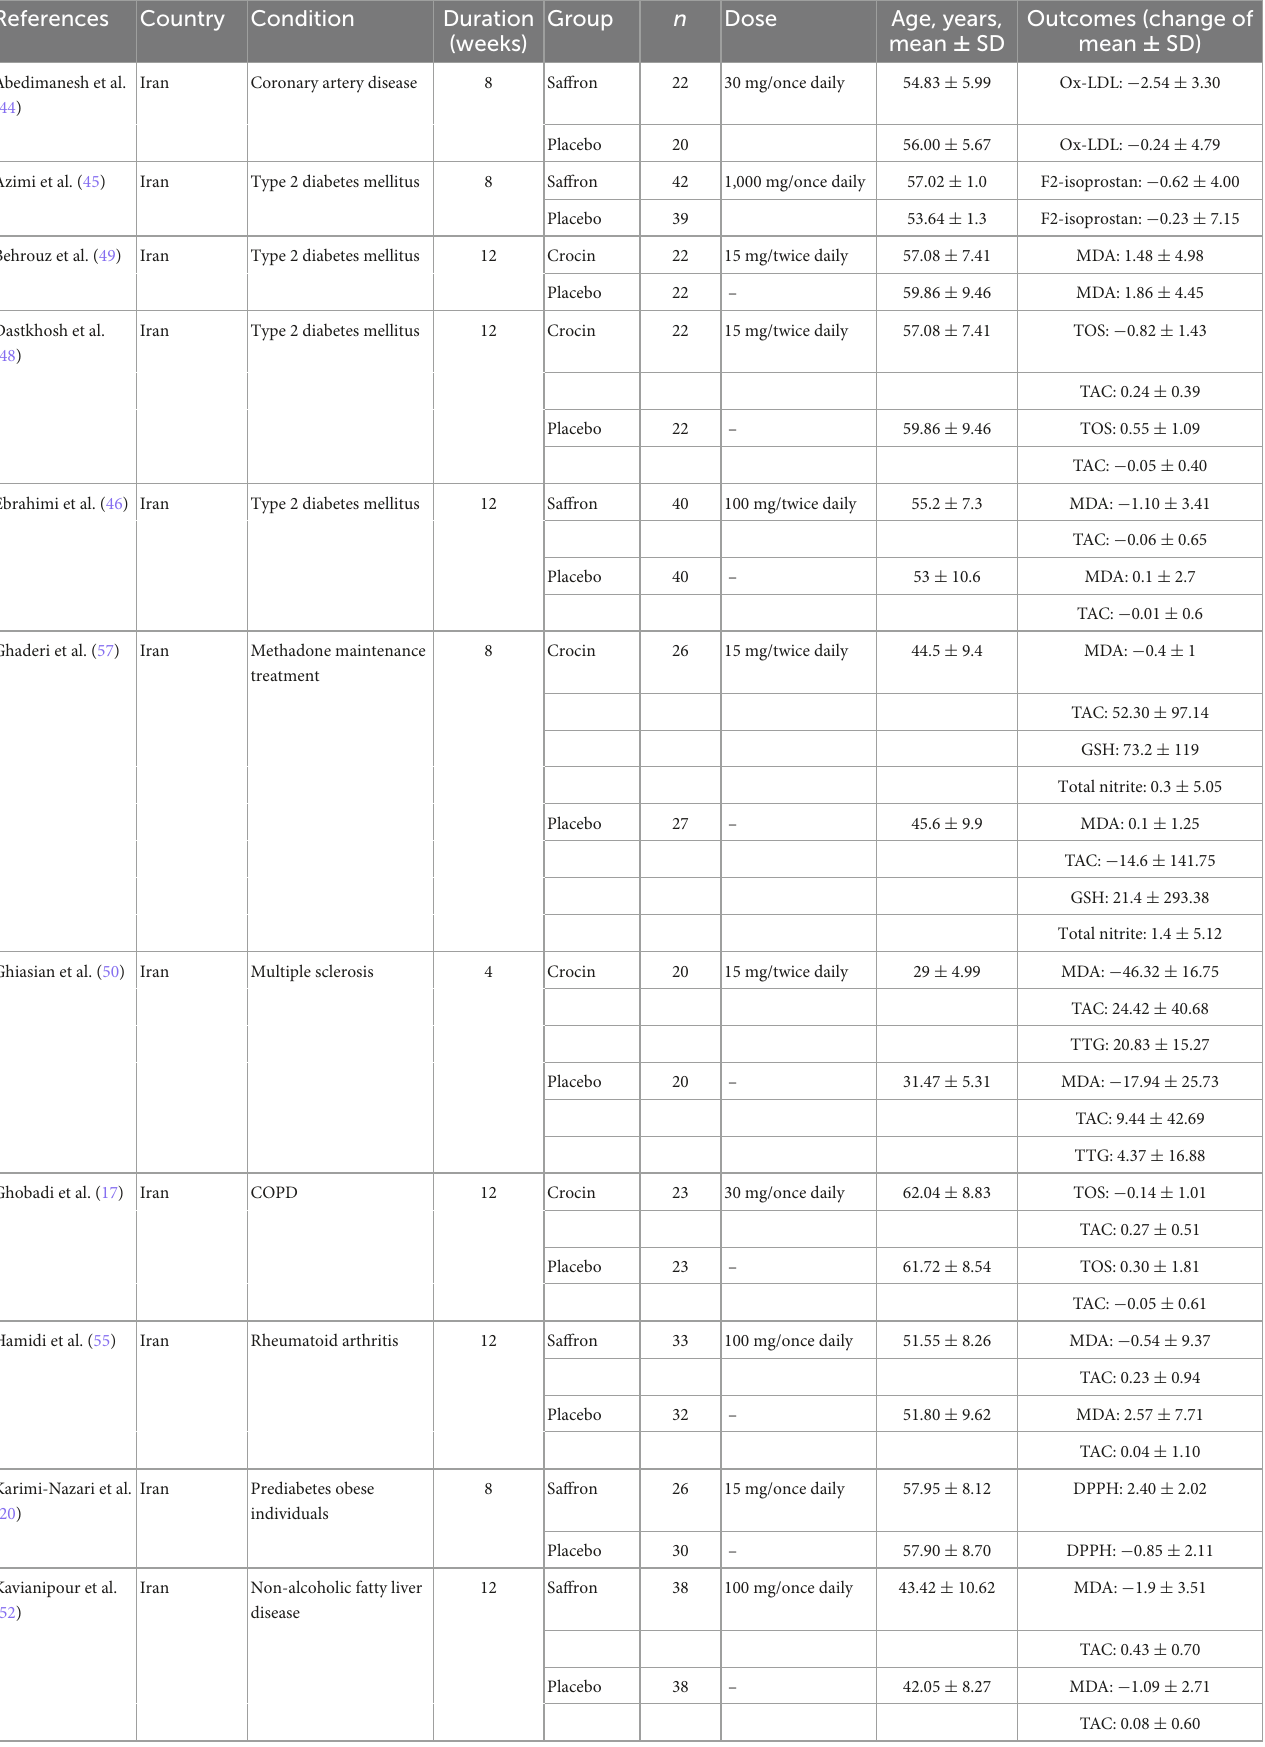
TABLE 2 Characteristics of included studies investigating the effects of saffron supplementation on serum concentrations of oxidative stress